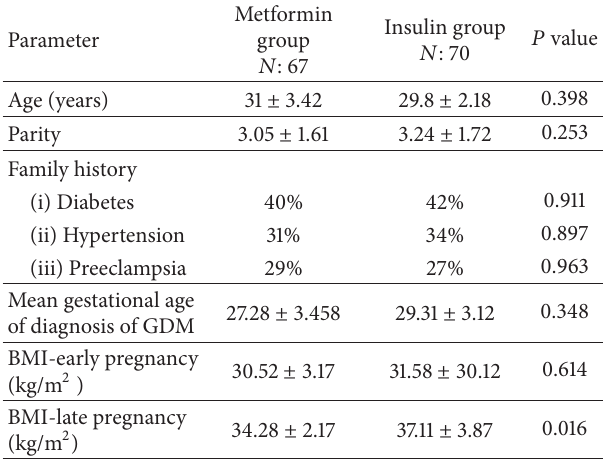
Table 1: Demographic profile of metformin and insulin groups.